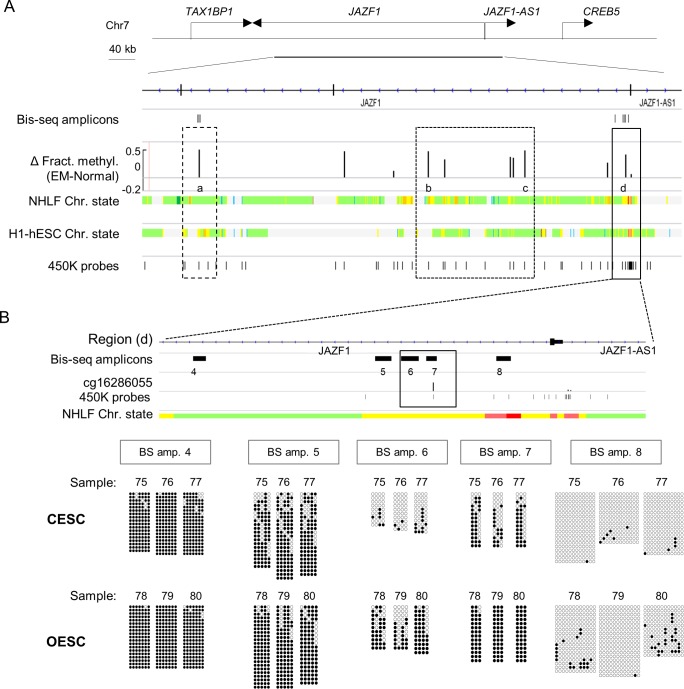
Gain of DNA methylation in the promoter and gene body of JAZF1.A) Map showing multiple clusters of hyper-methylated CpGs in the promoter and gene body of JAZF1. The dashed and plain rectangles indicate clusters of CpGs with DM overlapping multiple individual enhancer regions. B) Validation and mapping of the DMR (d) in JAZF1 gene using bis-seq. The results from the Bis-seq for the amplicons indicated with number on the higher resolution gene map (top) are shown as QUMA blots (bottom). Every circle represents a single CpG. Black circles indicate methylated CpG and the white free of methylation CpG. The number of the amplicon and each individual sample ID are indicated on the top of every QUMA. The bis-seq data identify this DMR as a large 2.75 KB region spanning amplicons 5, 6 and 7.